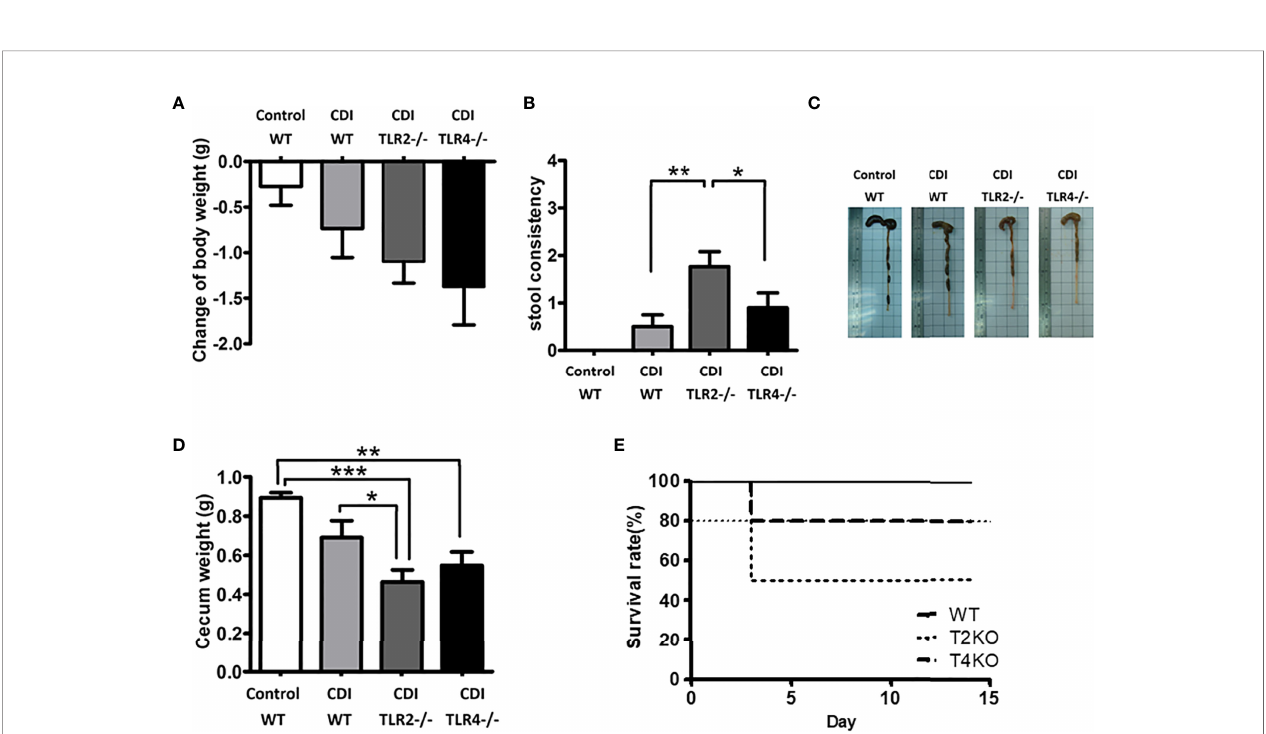
FIGURE 2 | Disease progression of CDI in mice of different genotypic backgrounds (WT, wild type; TLR2 de fi ciency: Tlr2-/-; TLR4 de fi ciency: Tlr4-/-). Mice were fi rst treated with an antibiotic mixture for 2 days and then challenged with C . dif fi cile or saline. Body weight change (A) , stool consistency (B) , length (C) or weight (D) of the cecum and colon at day 2 of infection were measured. Two-week survival rates of the 3 groups with CDI are shown ( E ; n = 23-25 mice/group, P = 0.86). Values are expressed as means ± SEMs. (* P < 0.05; ** P < 0.01; *** P <